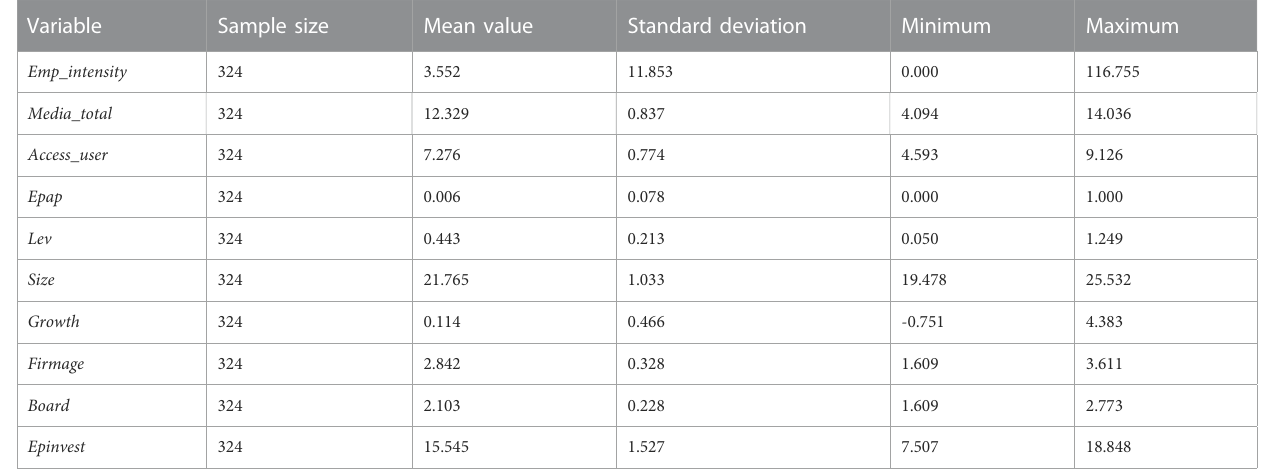
TABLE 2 Descriptive statistics of the main